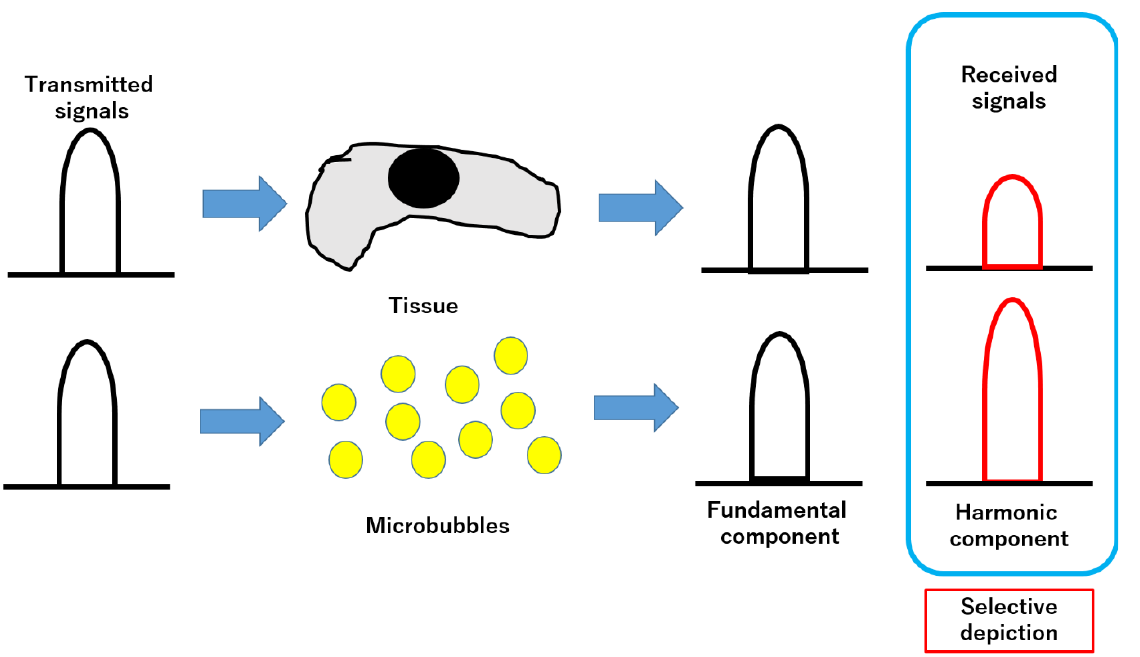
Figure 1. Basis of contrast harmonic imaging. When irradiated with an ultrasound beam, the microbubbles in the contrast medium vibrate. Many harmonic signals are emitted. At this time, when the transmitted ultrasound is received transmitted ultrasound is received, both the tissue and the microbubbles generates harmonic components from the microbubbles. Harmonic components from microbubbles are at higher levels than harmonic components from tissue. The harmonic components from the microbubbles are at a higher level than the harmonic components from the tissue. By selectively delineating the second harmonic component, the signal from the microbubbles is visualized more strongly than the signal from the tissue.